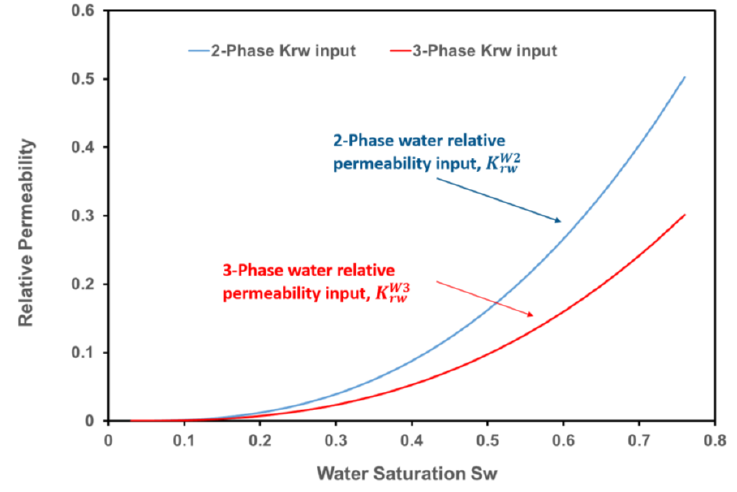
Figure 16. Phase and 3-Phase relative permeability input for the Larsen and Skauge model.